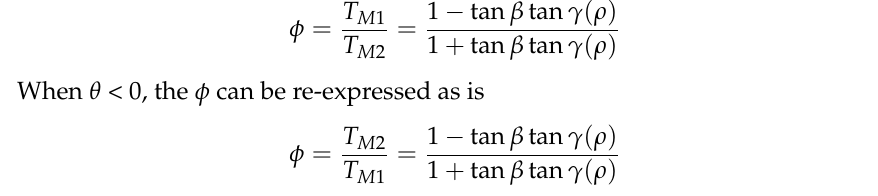
Figure 7. Shape of the pitch curve based on different cases. Figure 8. Stiffness resolution based on different cases.